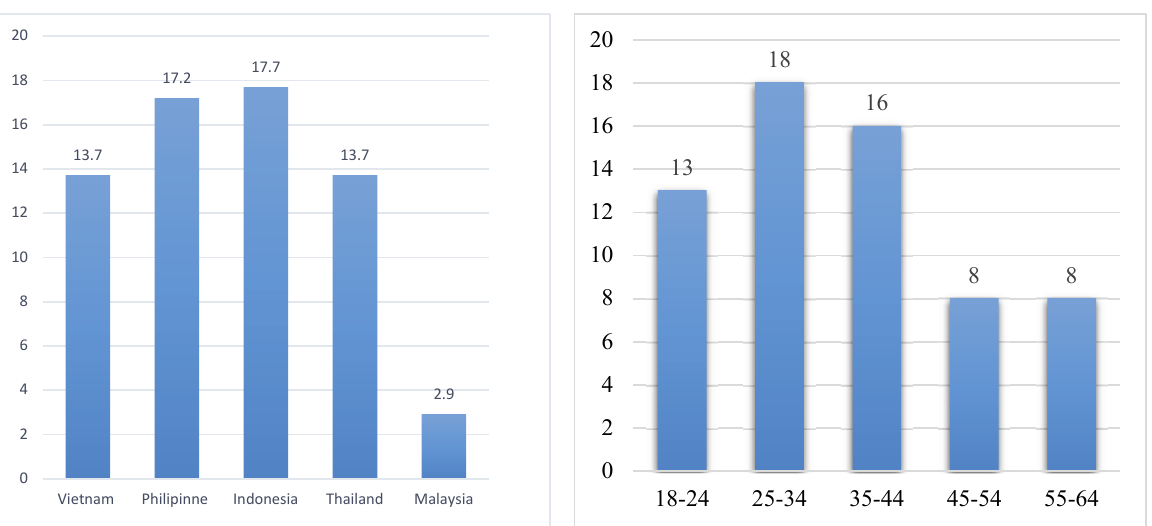
Fig.2. Entrepreneurial development of some countries in ASEAN region in 2015 (unit: %)